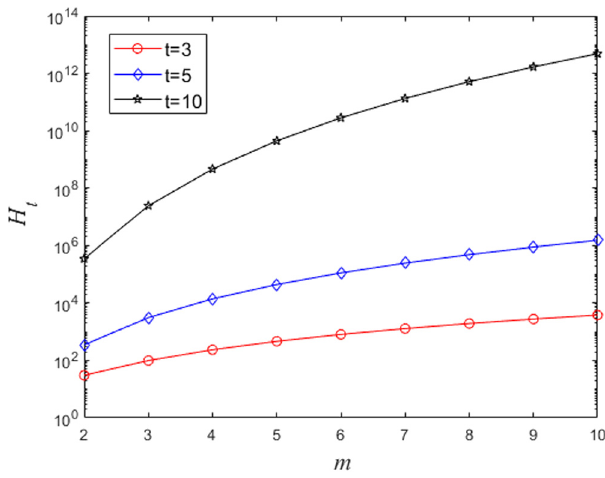
Figure 5: When t is fi xed, H t increases monotonically with m for ≥ m 2